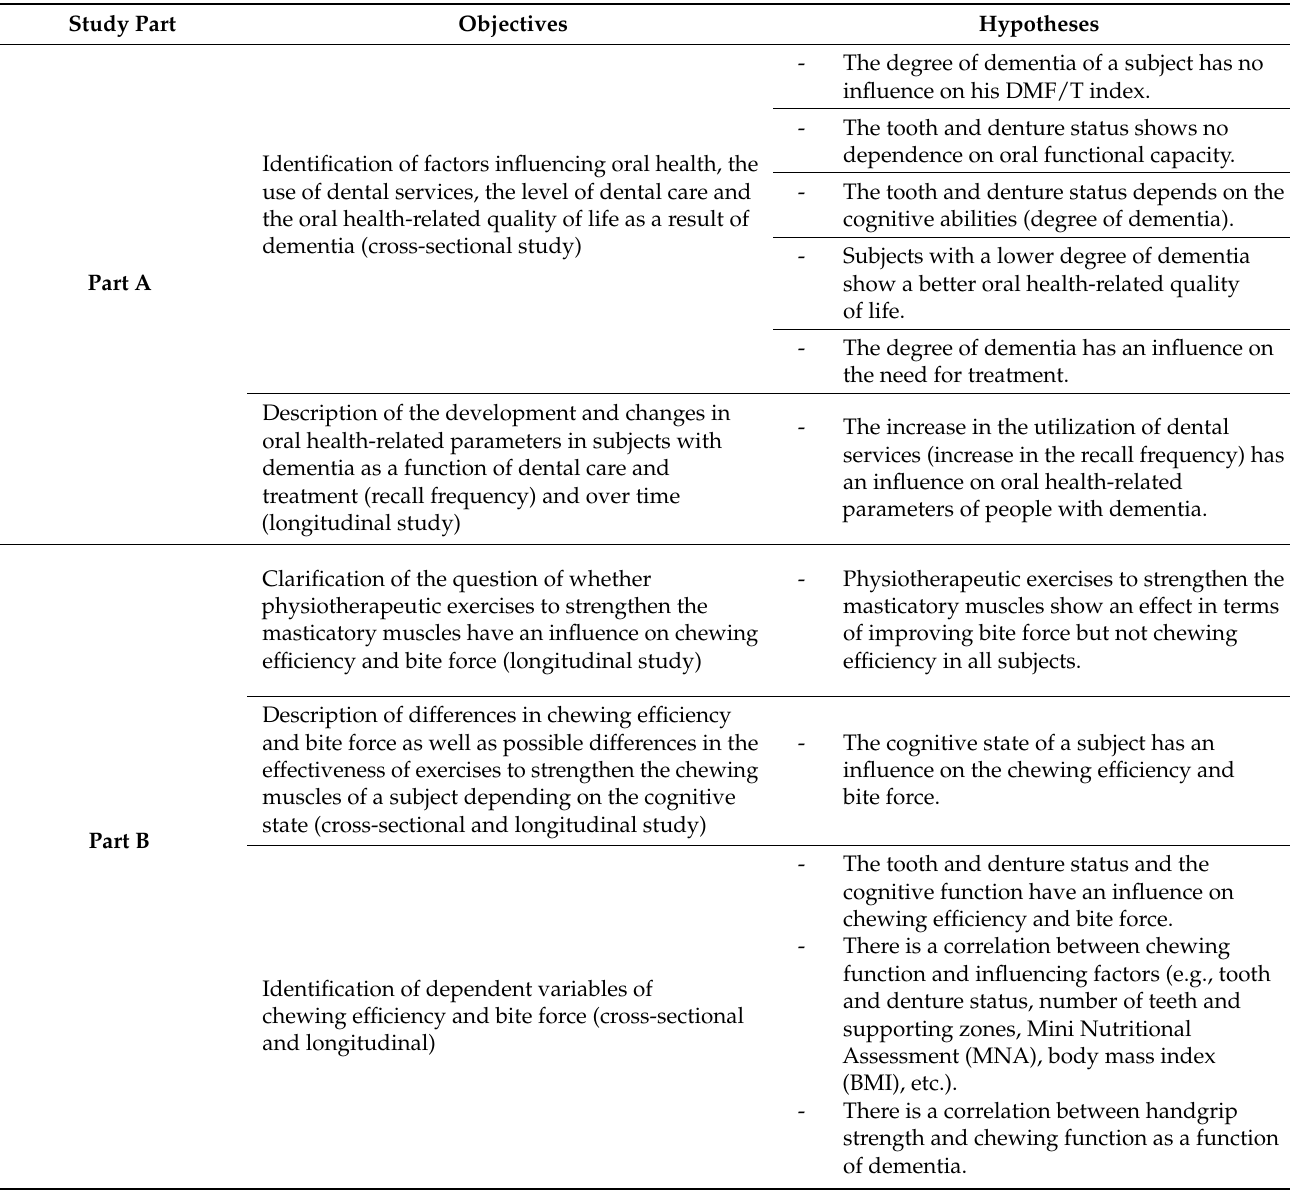
Table 2. Objectives and working hypotheses for the crossed arm study part A—oral health (main influencing parameter increase in oral and denture hygiene) and study part B—chewing function (main influencing parameter physiotherapeutic exercises to train the masticatory